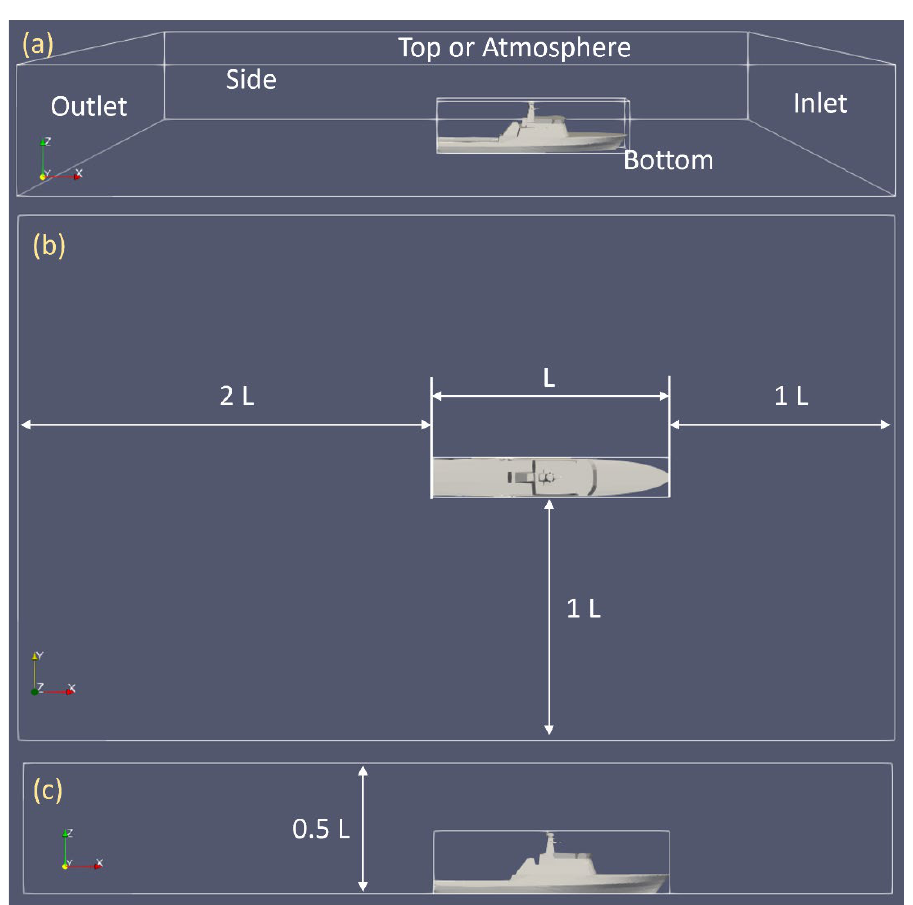
Figure 2. The domain size and the general boundaries used in the simulations, showing ( a ) the name of each boundary, ( b ) the dimensions in the x and y directions, ( c ) the dimension in the z-direction of the domain.